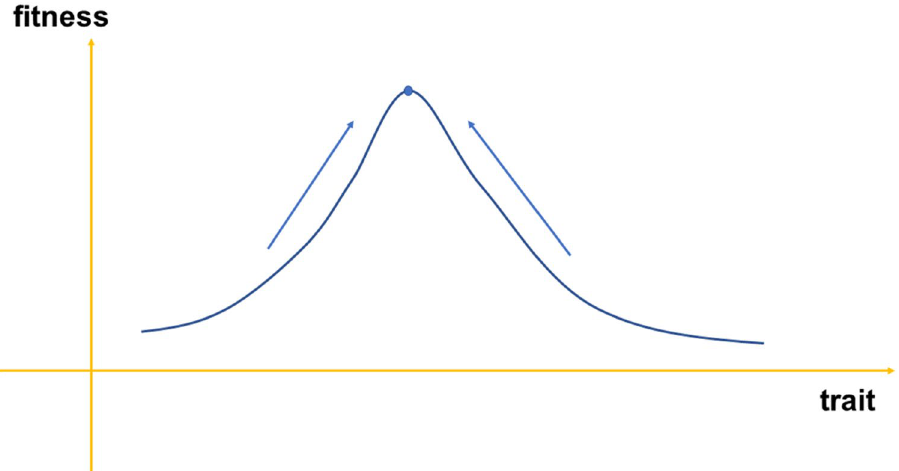
Figure 2. The evolutionary for the constant fitness distribution. In the traditional Price equation, where the fitness is constant, evolution always point to the equilibria. It is irrelevant to the traits. The evolution is only determined by the stationary fitness distributions and all the individual will evolve to position corresponding to the fitness